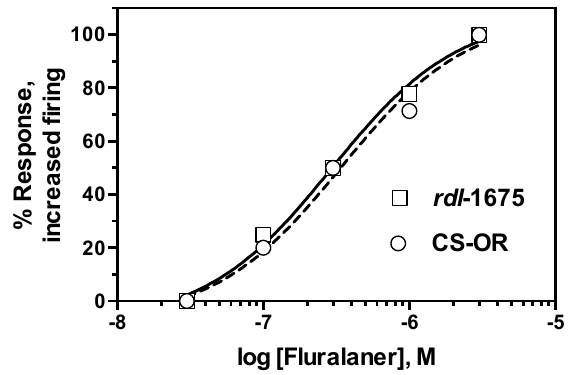
Figure 9. Concentration response curve (% responding preparations) of fluralaner on resistant and susceptible strains of D. melanogaster , in transected larval CNS recordings. Fluralaner was added after a 5-min incubation of 1 mM GABA to inhibit nerve activity. Solid line and dotted line represent curves for rdl -1675 and CS-OR preparations, respectively.